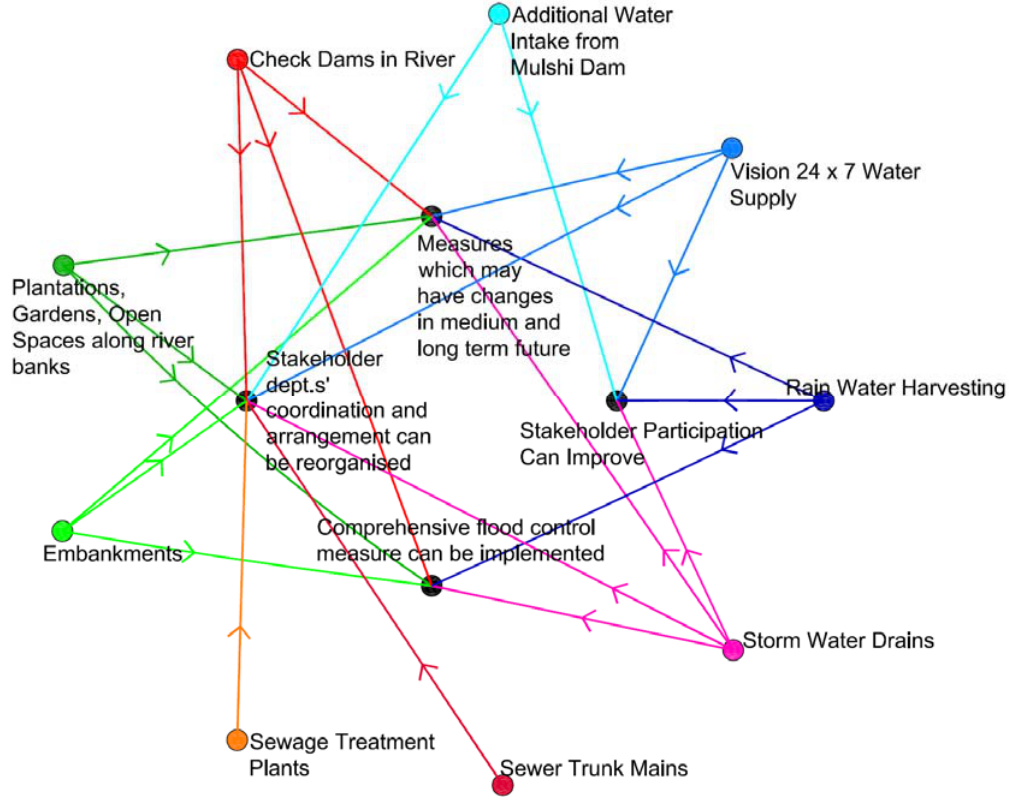
Figure 7. Possible collaboration between adaptation responses (The arrows represent the contribution of response to the common goal, i.e., the arrows originate from the adaptation responses and terminate at the favourable outcome(s) that the adaptation responses are likely to yield during planning or implementation).